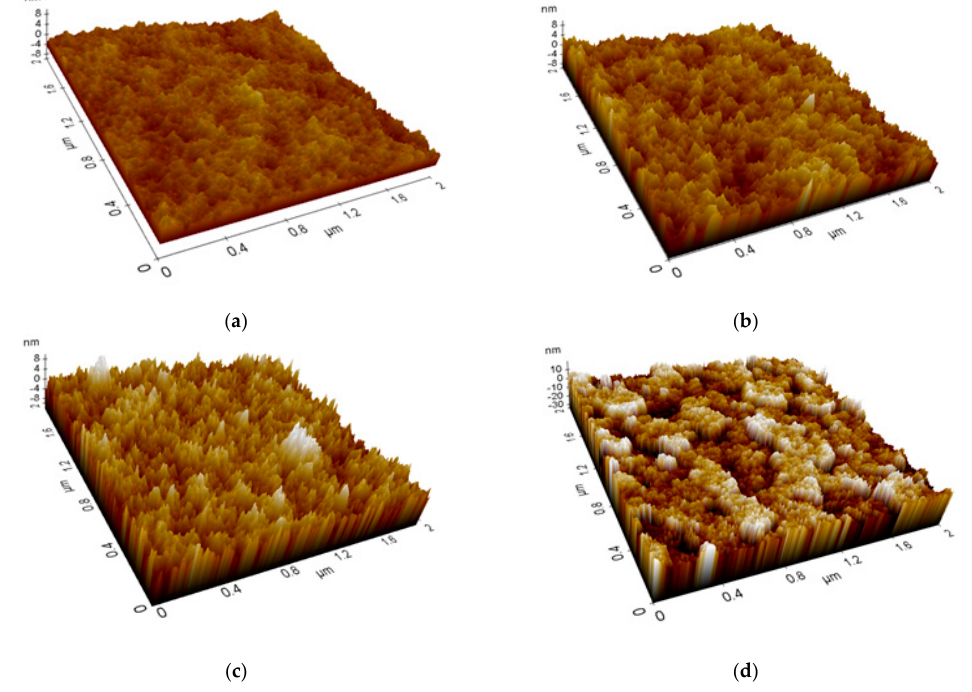
Figure 7. The atomic force microscopy (AFM) images of ( a ) single layer PEDOT:PSS films; ( b ) multilayer PEDOT:PSS films; ( c ) multilayer PEDOT:PSS films treated with organic acid; and ( d ) Indium tin oxide (ITO).